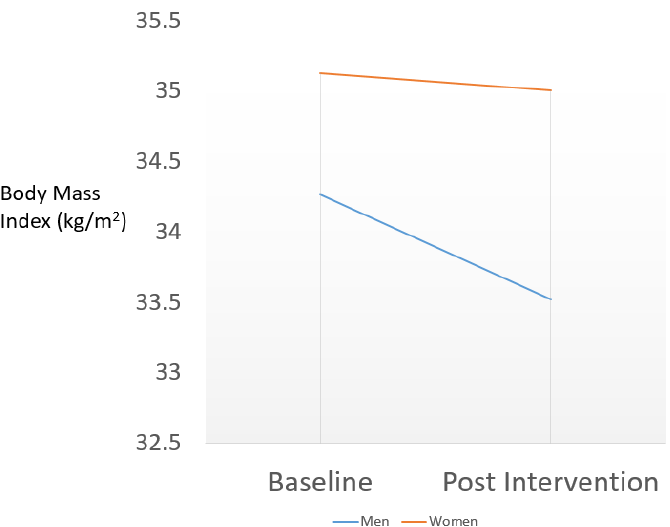
Figure 2. A baseline to post-intervention decrease in body mass index (BMI) among Hispanic/Latino Parent/Guardians in the Healthy Eating and Lifestyle Program who are overweight/obese (Body Mass gender and follow-up